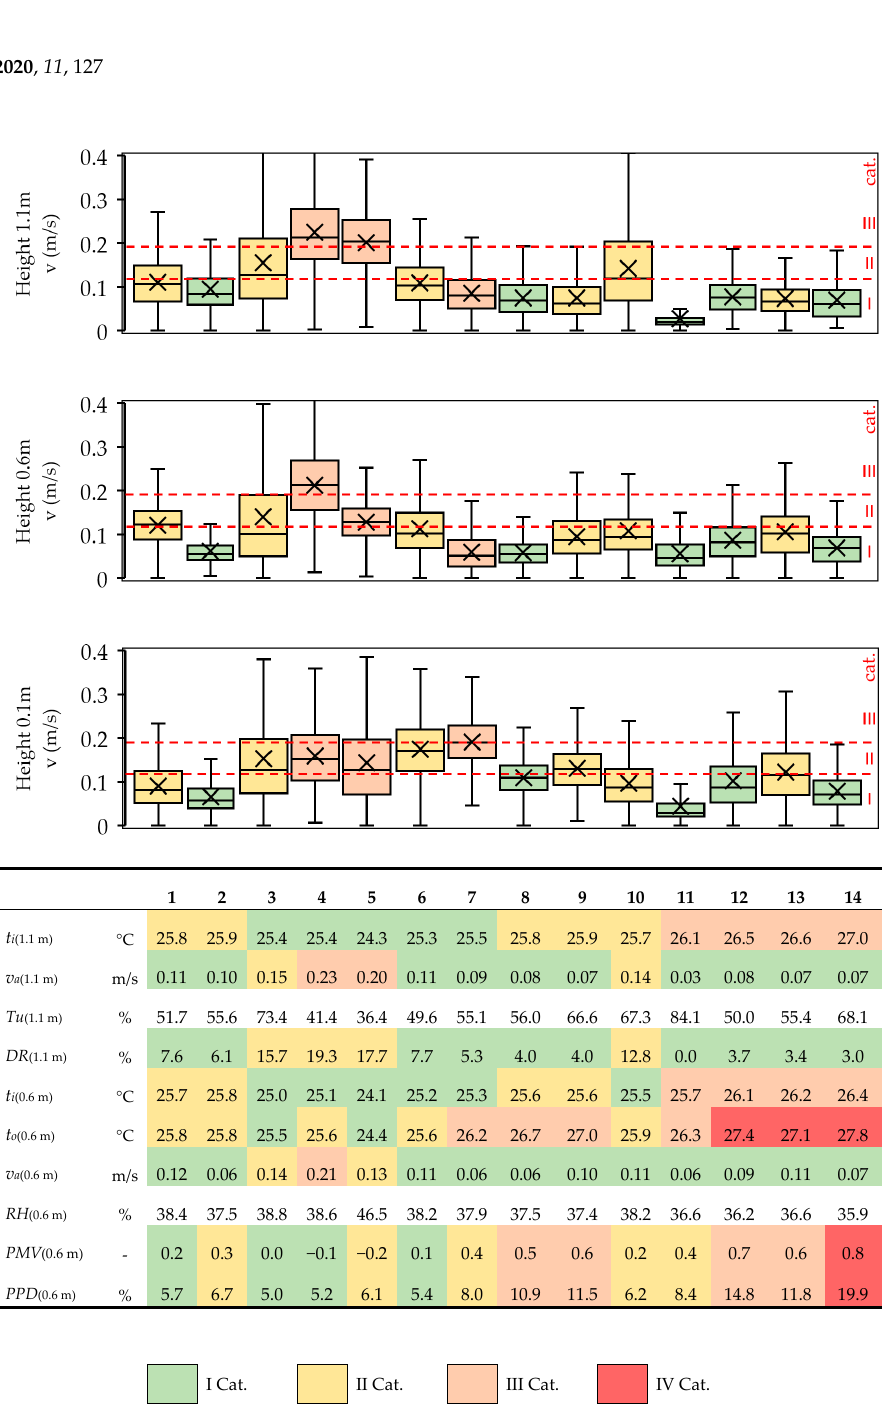
Figure 8. Building E air velocity results in measurement points 1–14 and the thermal comfort parameters.